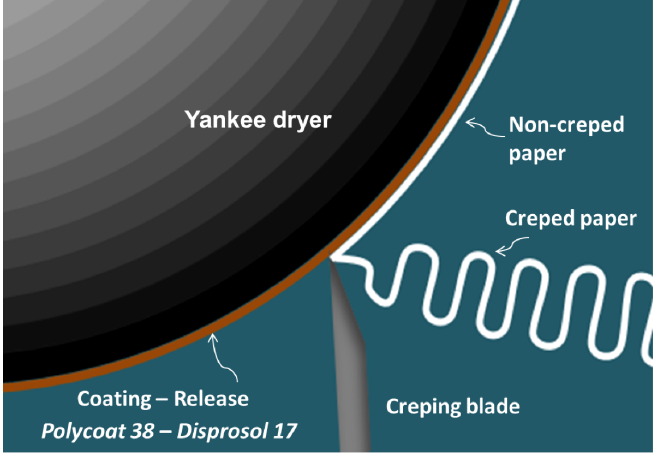
Figure 1. Scheme of the creping process using a coating-release agent in the yankee dryer.